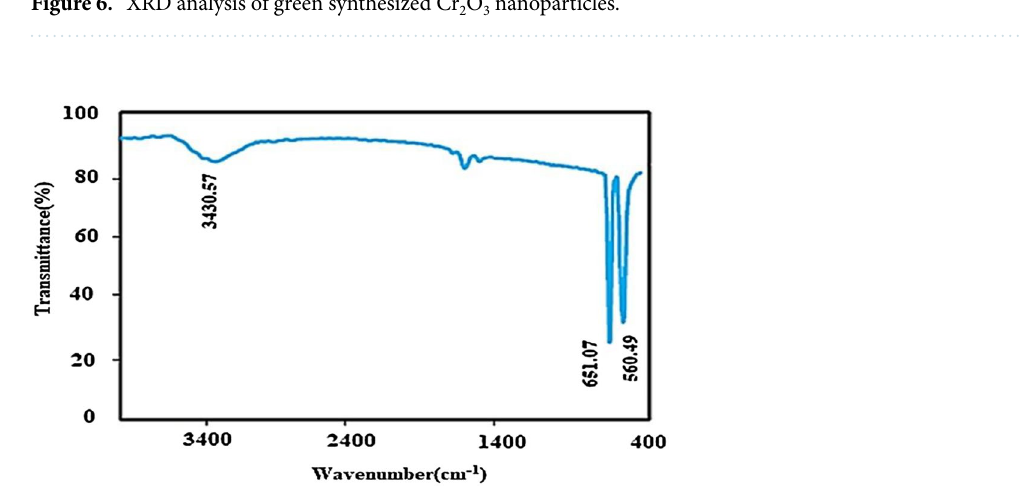
Figure 7. FT-IR spectrum of the green synthesized Cr 2 O 3